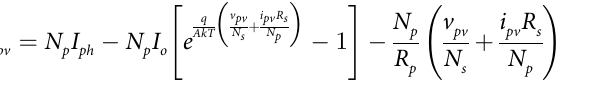
constant (1.38 × 10 − 23 J / K ), T represents the PN–junction temperature ( K ) and A denotes the diode ideality factor (or constant), where usually: 1 � A � 1.50.